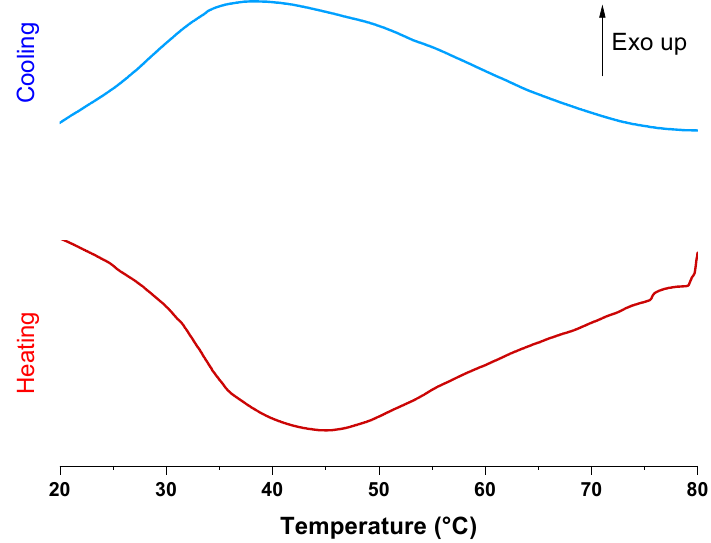
Figure 7. Reversible phase-transition of the films observed in the differential scanning calorimetry (DSC) runs (sample F1).